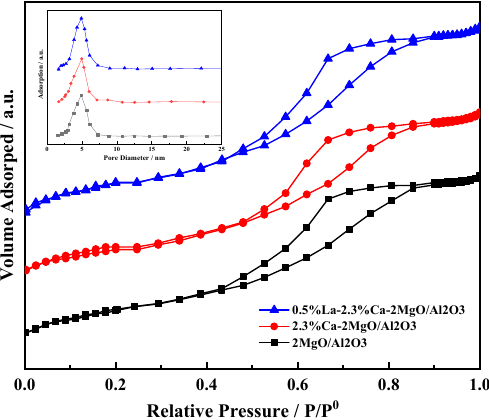
Figure 2. XRD patterns of composite oxides.